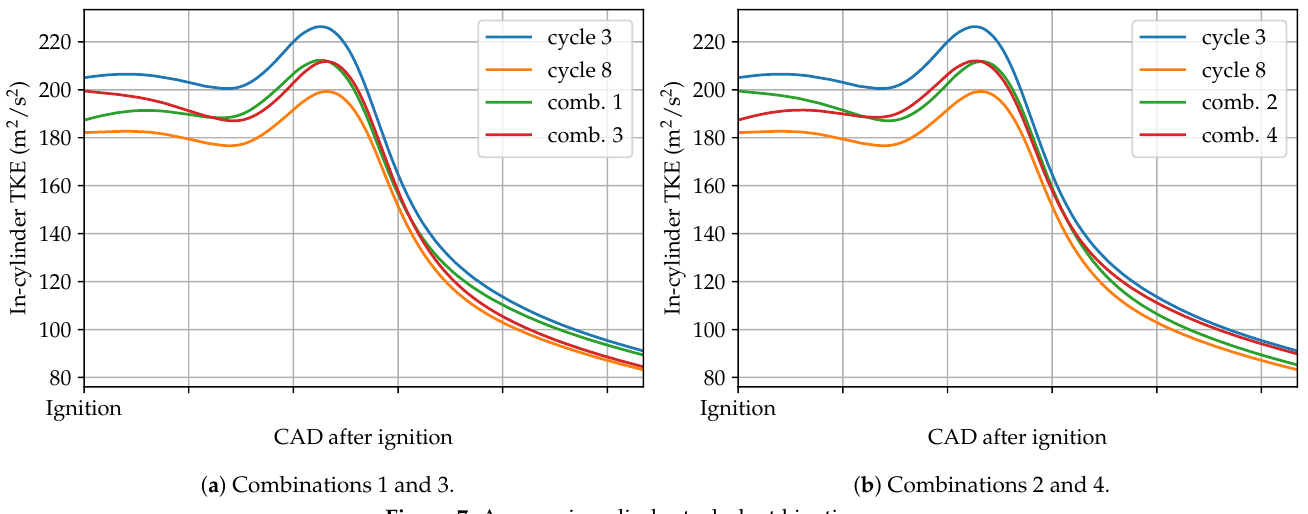
Figure 7. Average in-cylinder turbulent kinetic energy. Combinations 5, 6 and 7 use the flow field in a spherical volume around the ignition location of cycle 3 and all other quantities and the flow field outside of said volume of cycle 8. The in-cylinder pressure and rate of heat release are shown in Figure 8. The time before ignition when the snapshot is taken is 5 CAD. The figure shows that the larger the spherical volume the closer the cylinder pressure is to cycle where the velocity field is sourced with the peak cylinder pressures for combinations 5, 6 and 7 of 25.9%, 72.1% and 82.7% for radii 1 cm, 2 cm and 5 cm, respectively with 100% corresponding to the cycle from which the near spark plug flow field is extracted.